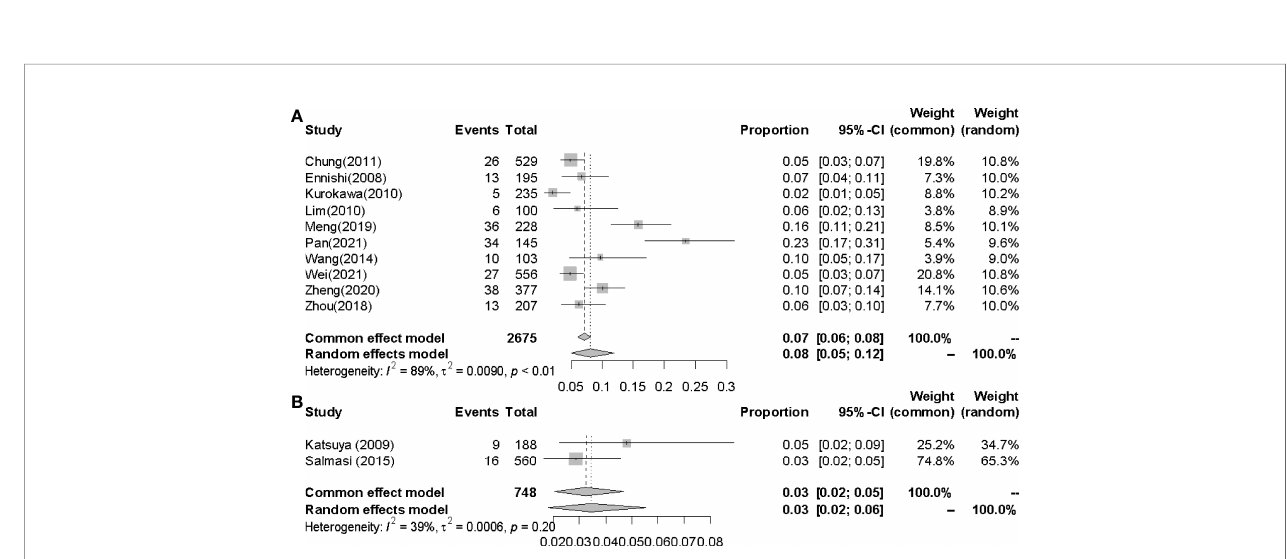
FIGURE 7 | Incidences of IP in Easterners and Westerners. (A) Easterners. (B)